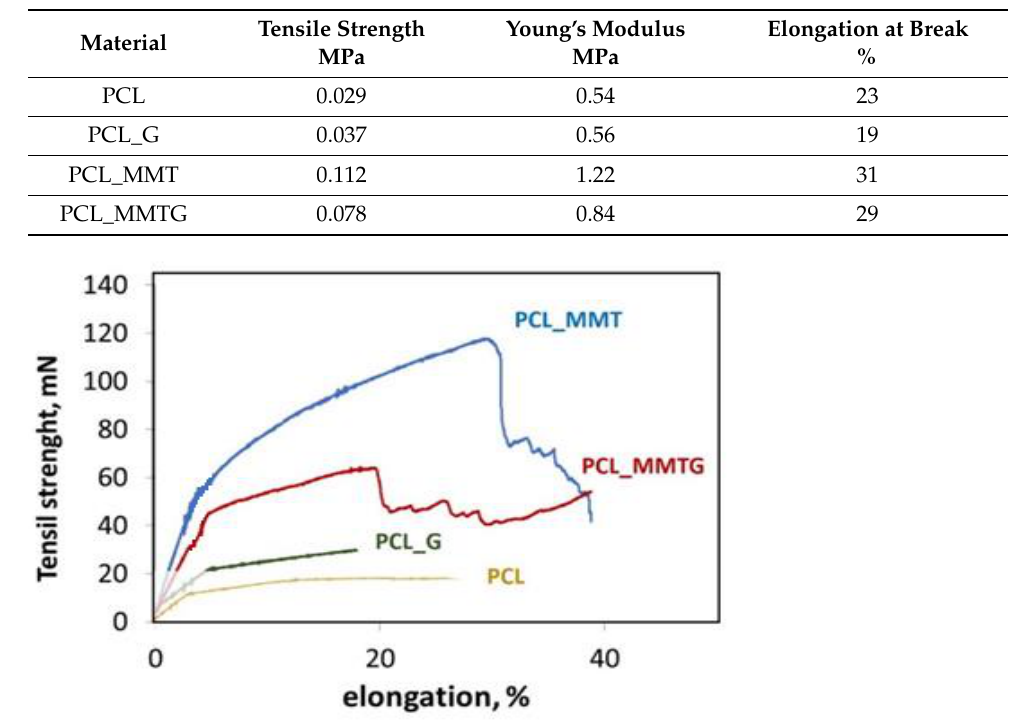
Figure 6. Force-elongation curves recorded during mechanical tests of nanobiocomposite mem- branes: PCL_MMT, PCL_MMTG and PCL_G and the reference PCL polymer